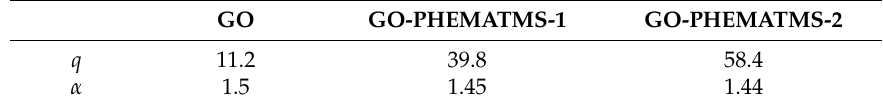
Figure 7. Values of the yield stress vs. the electric field strength for ER fluids consisting of various particles under investigation. Table 2. Parameters of Equation (1) for 5 wt.% ER fluids consisting of various particles under investigation.